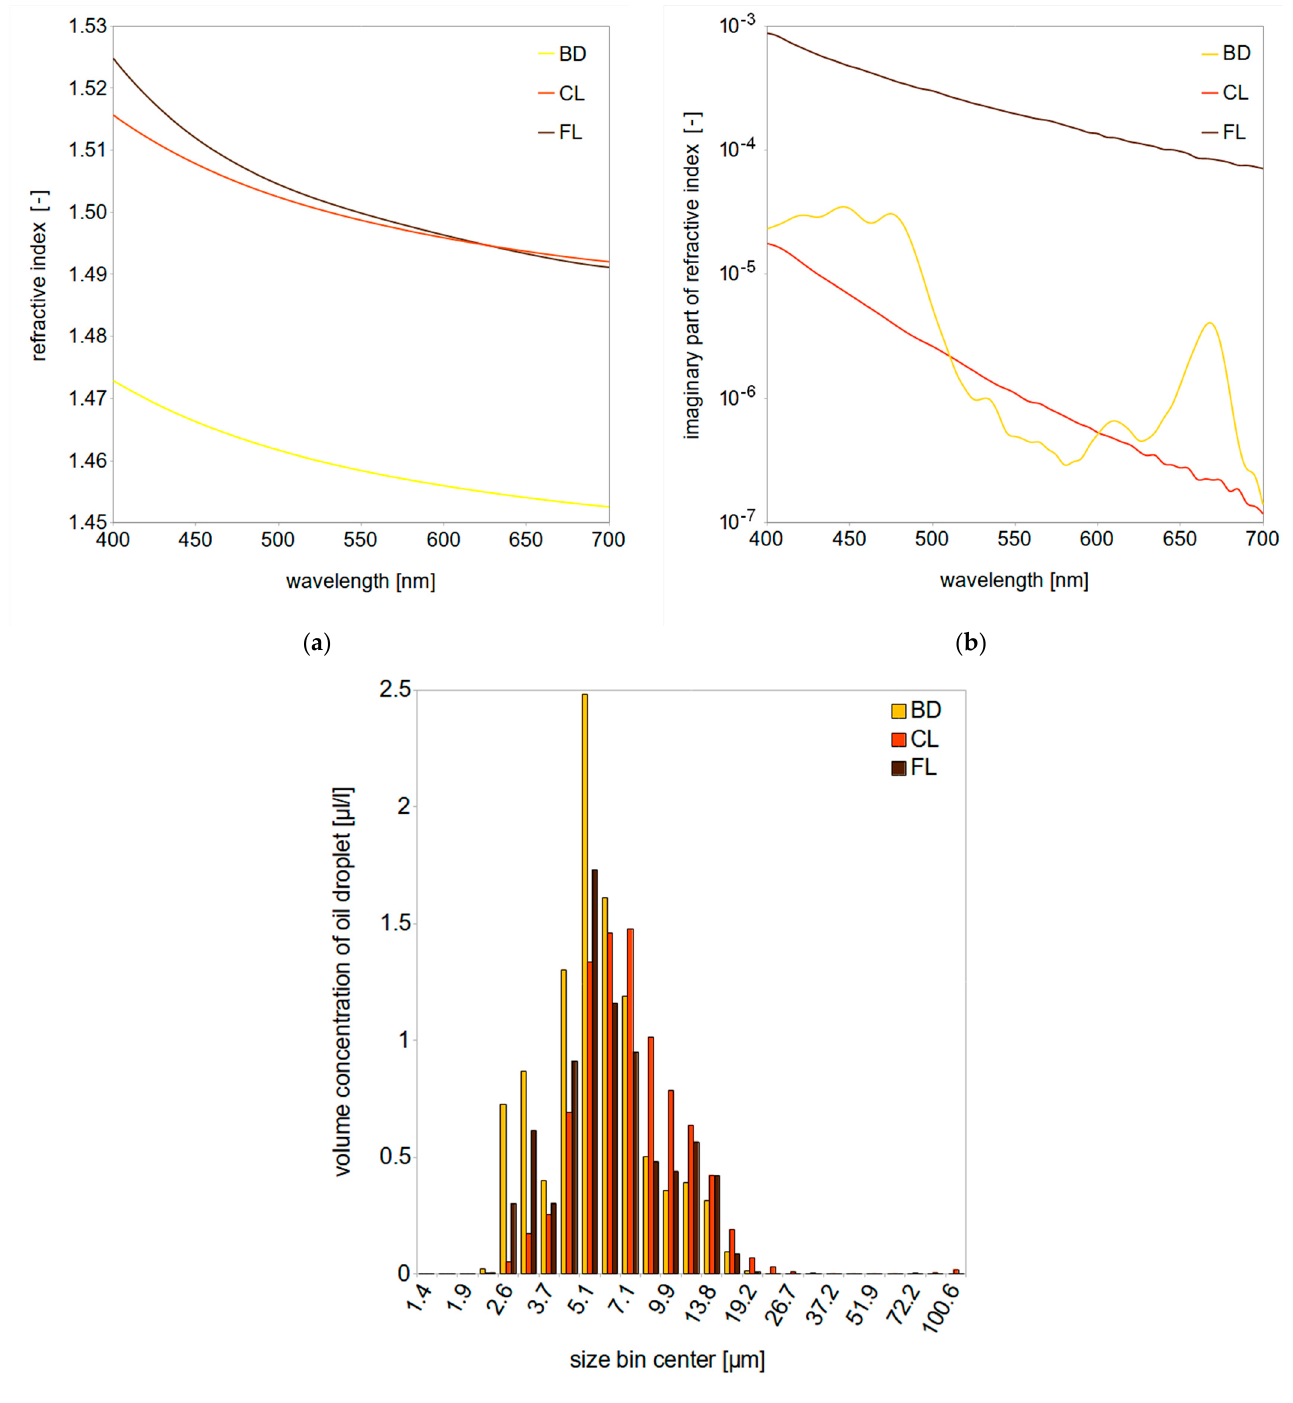
Figure 2. ( a ) Real part of refractive indices of oils measured using multispectral refractometer DSR- λ ; ( b ) imaginary part of refractive indices of oils obtained from absorption measurements by spectrophotometer Perkin Elmer Lambda 850; ( c ) oil droplet size distributions measured using LISST-100X.